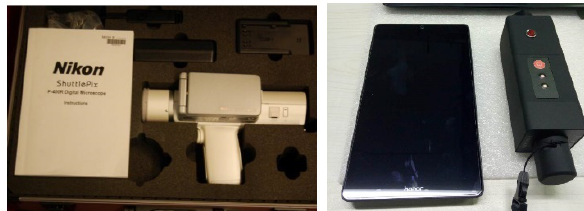
Figure 8 . The Nikon hand-held microscope and the crack width observation instrument. (Source: Tongji-ACL) Over 30 micro cracks were identified and labeled under the in- situ microscopes. The dolomite crystal fabric on the surface wore off with different degrees, and even small marble pieces were peeling off (Figure 9).